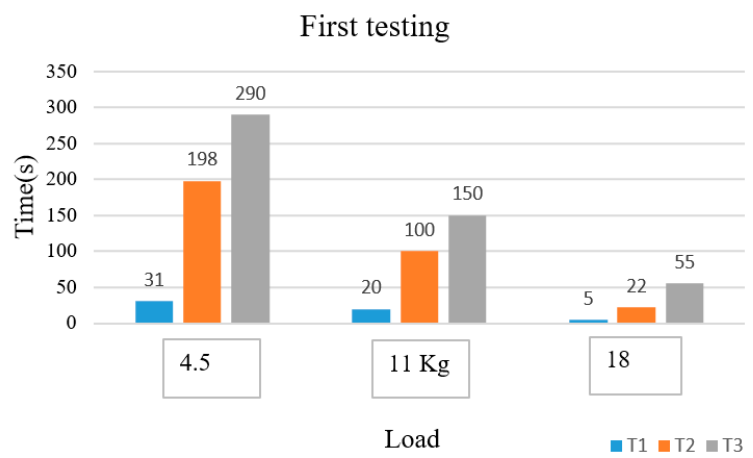
Figure 12. Parameters of time fatigue with different loads in the first testing.